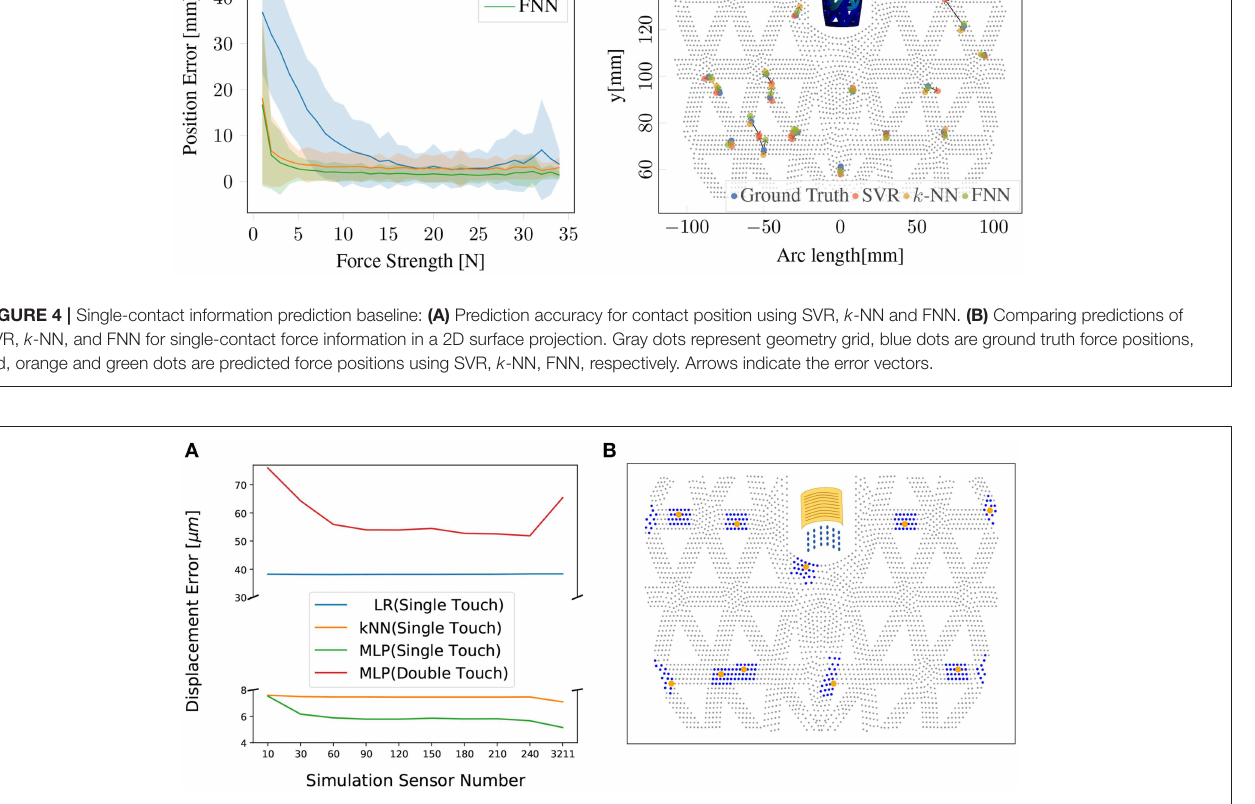
FIGURE 5 | Transfer learning maps the physical sensor values to simulated sensor values: (A) The effect of number of simulated sensors on the prediction precision (of the full displacement map) evaluated with three methods: Linear regression (LR), k -NN, and FNN ( F T ). Training was conducted on a large set of single-contact data and the reported test performance is for single-contact and double-contact data collected on the real system. The reconstruction net F R was trained on simulated multi-contact data. Twenty-four sensors per physical sensor yielding 240 sensors is optimal for generalizing to double contact prediction. (B) The yellow dots are the centers of physical SGs (optimally selected in Sun and Martius, 2018) and the yellow sheet illustrates the real physical SG. The blue dots around each SG’s center are the simulated sensor points (nodes in finite element simulation ANSYS ).